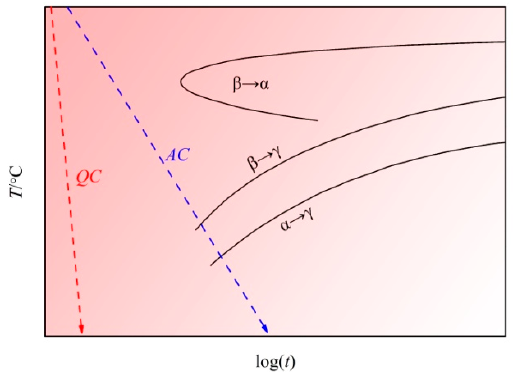
Figure 3. Schematic of TTT (time–temperature–transformation) diagram to show the decomposition pathways of β phase in V-rich TiAl alloys. The data of the map was quoted from Ref. [11]. Note that this diagram is for Ti-42Al-8V but can roughly describe the β -decomposition pathways for the present Ti-40Al-10V alloy.